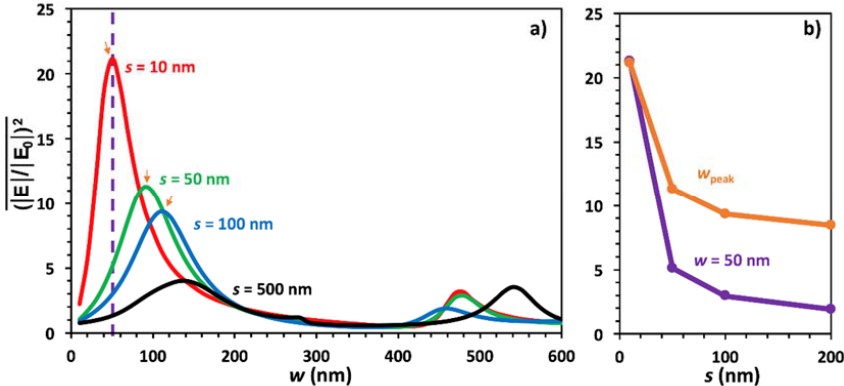
Figure 2. ( a ) Plot of line average enhancement versus w at s = 10 nm, 50 nm, 100 nm, and 500 nm; ( b ) plots the enhancement values from the peaks in ( a ) at different spacing values, w peak ; and plots the enhancement value for a constant width, w = 50 nm, for spacing values in ( a ). The vertical purple dashed line in ( a ) illustrates from where the data for w = 50 nm in ( b ) is obtained, and the orange arrows show points used for w peak . ( b ) Further, plot includes an additional data point not shown in ( a ) at s = 200